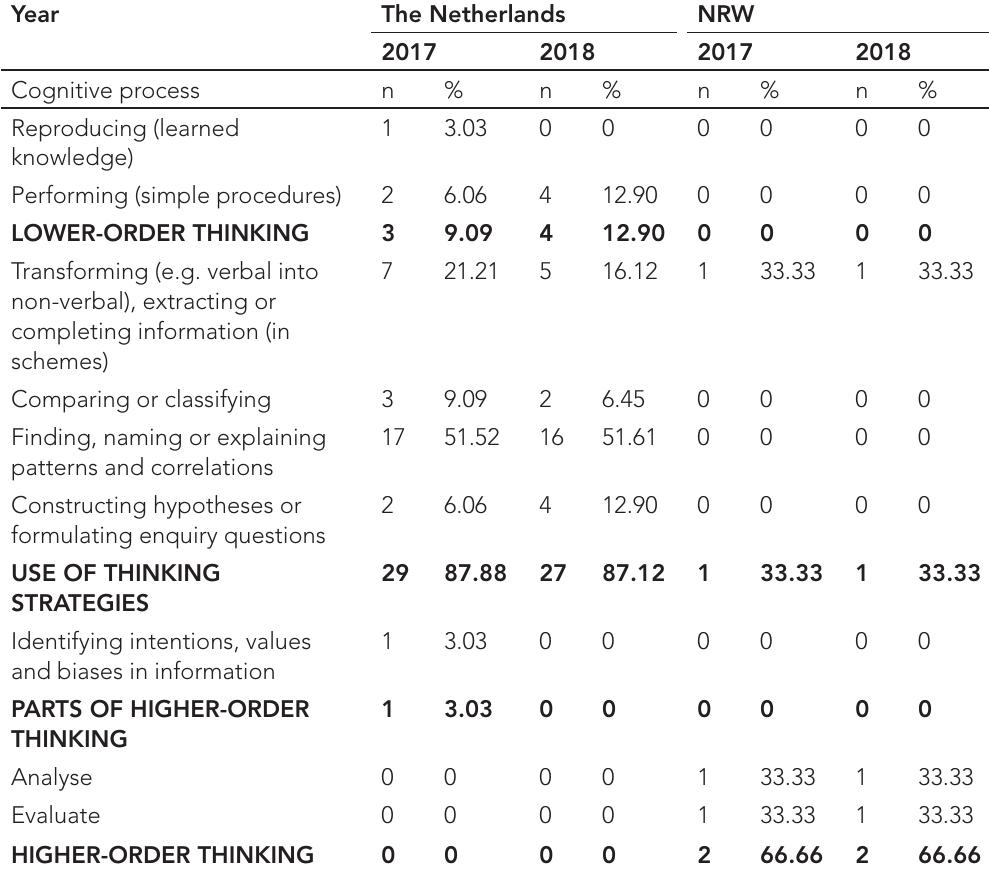
Table 4: Cognitive processes fostered by tasks in high-stakes examinations in the Netherlands and NRW in 2017 and